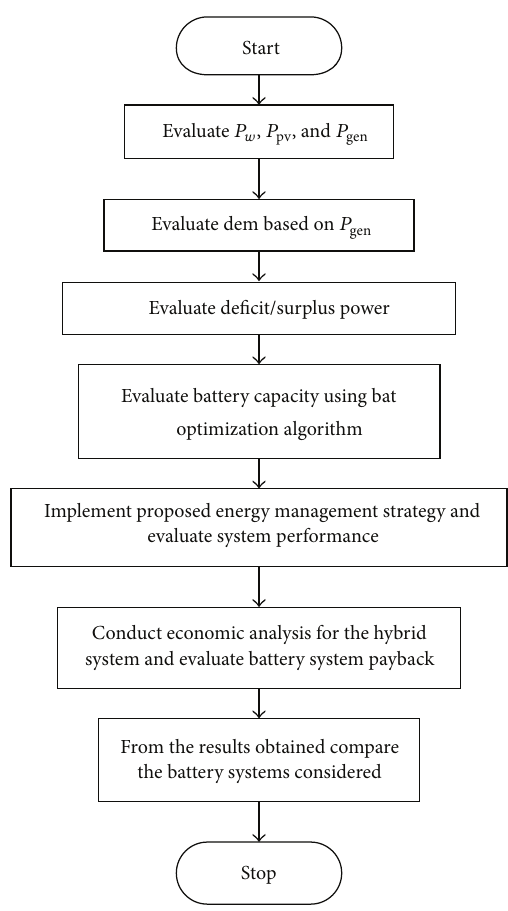
Figure 2: Energy storage sizing methodology.